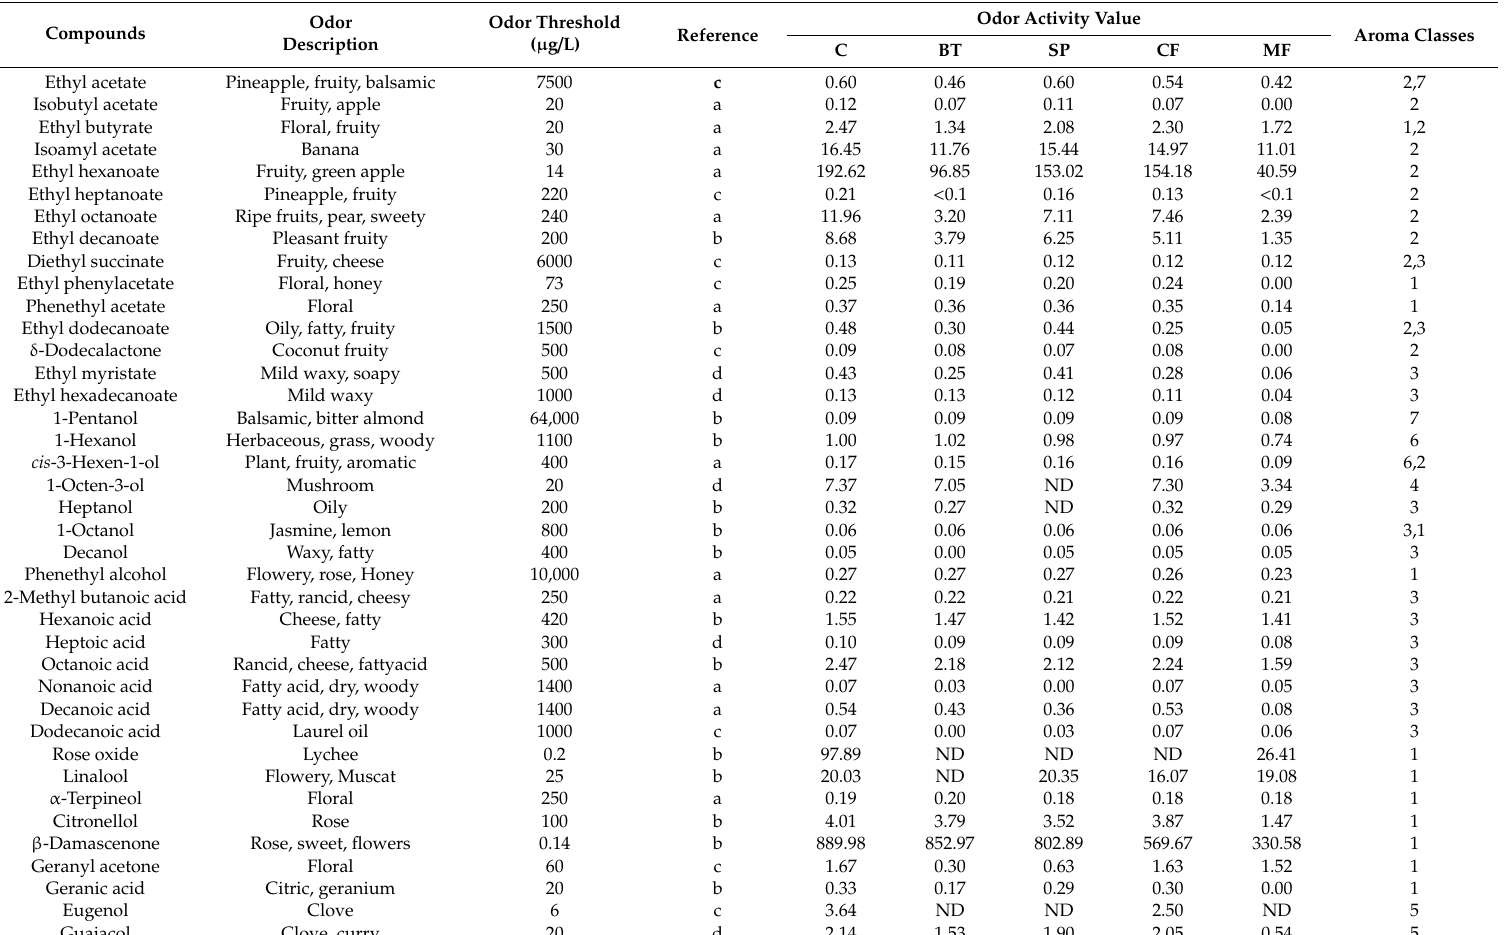
Table 3. Odor activity values (OAV > 0.1) and odor description of the would-be impact odorants of di ff erent clarified ice-wine